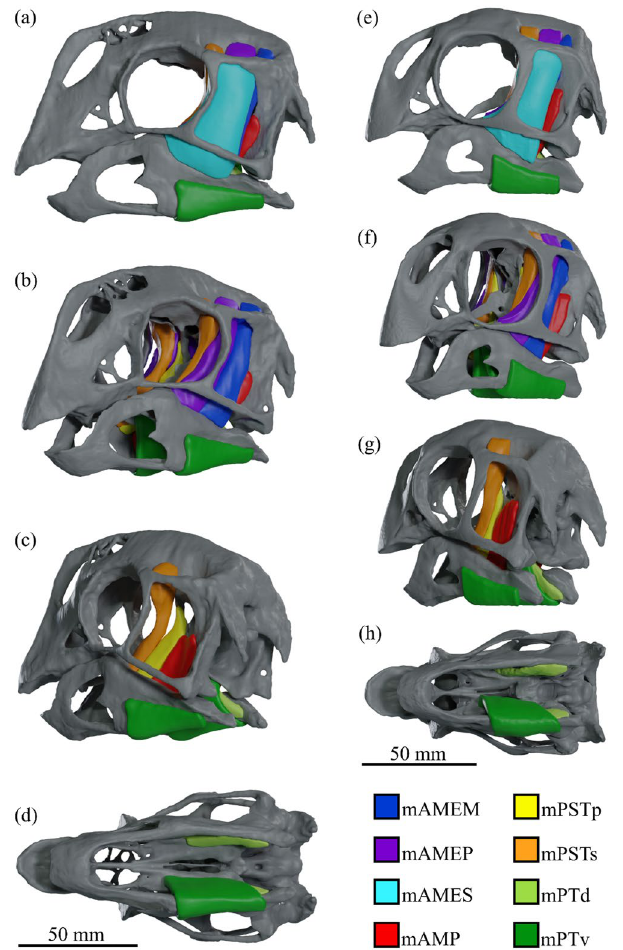
Figure 3. Reconstructed jaw adductor musculature of Khaan mckennai ( a - d ) and Conchoraptor gracilis ( e – h ) shown complete in lateral view ( a , e ), anterolateral view with mAMES removed ( b , f ), posterolateral view with mAME complex removed ( c , g ), and ventral view with only the mPT muscles (mPTv removed on left). Scale bars 50 mm, legend colour coded to identify individual muscles. Muscle abbreviations given in results